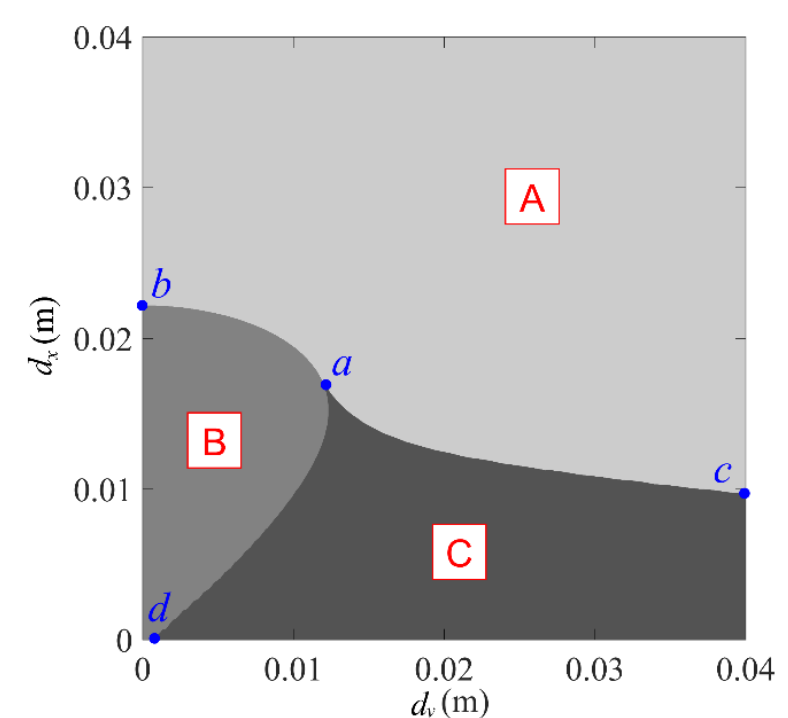
Figure 5. Bifurcated set of equilibrium positions.